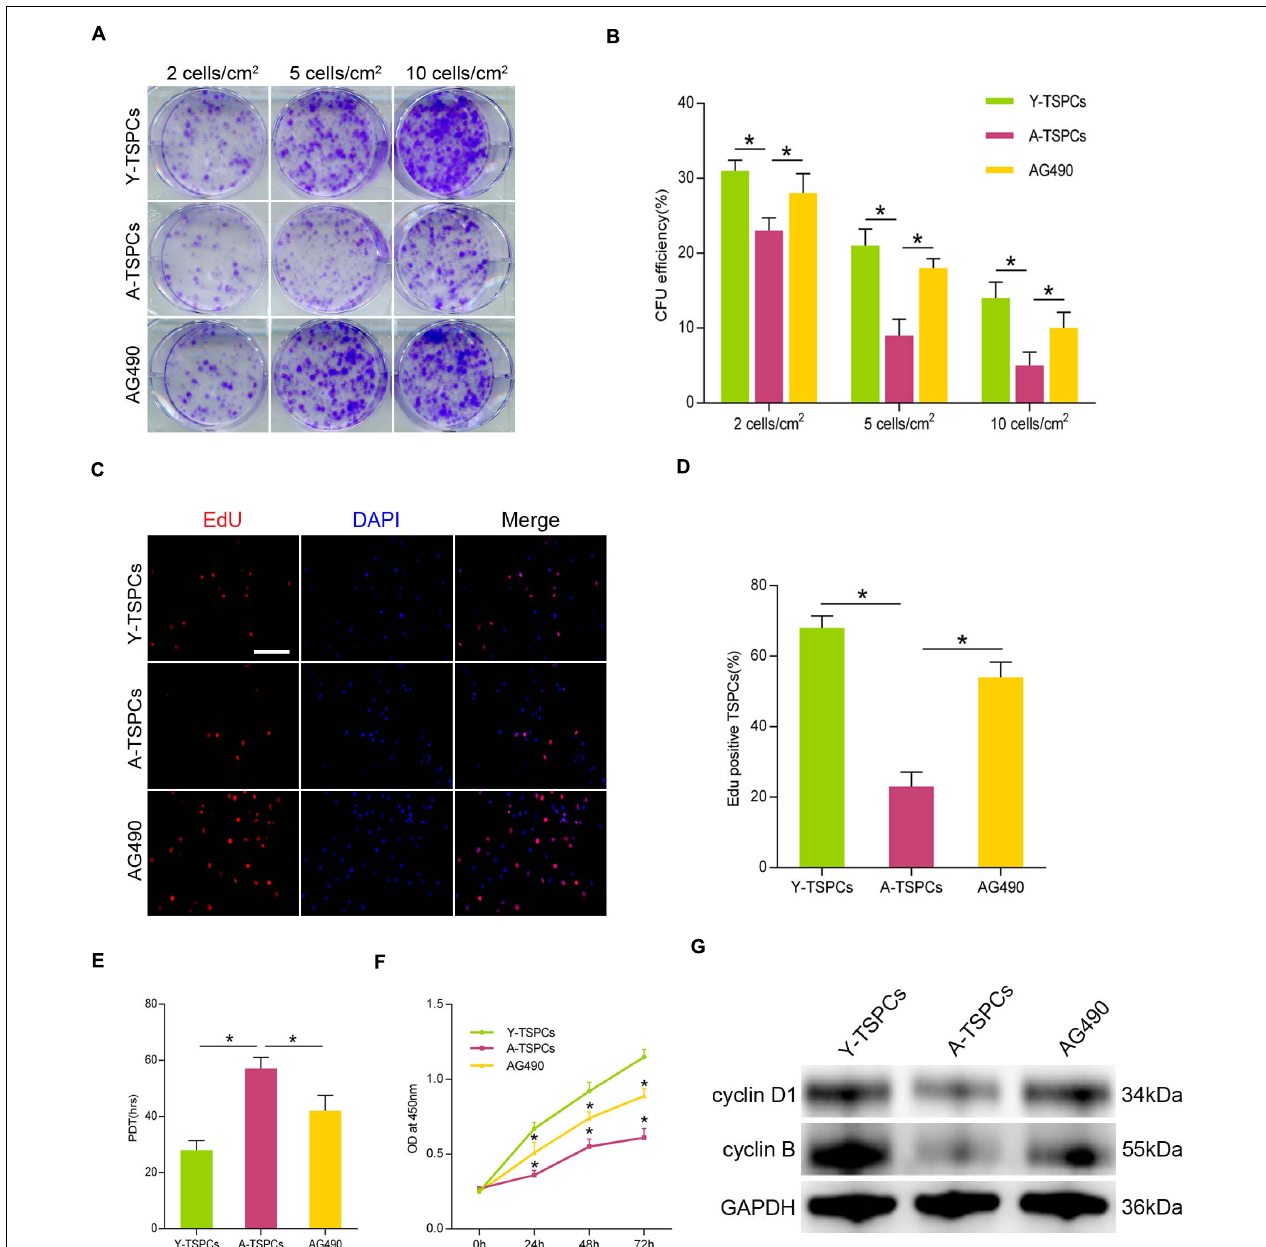
FIGURE 5 | Inhibition of JAK-STAT signaling pathway increases aged TSPC self-renewal. (A) Colony forming unit (CFU) assay showed multiple TSPC colonies stained with crystal violet at three densities. (B) Colony forming efficiency of young, aged, and aged AG490-treated TSPCs. (C , D) Representative images for EdU staining and EdU incorporation was quantified as EdU + cells/total cells. Scale bar: 50 µ m. (E , F) Cell proliferation was investigated by population doubling time (PDT) assay and CCK-8 assay. (G) The protein levels of cyclin D1 and cyclin B were analyzed by Western blotting. * P < 0.05 compared with the young or aged